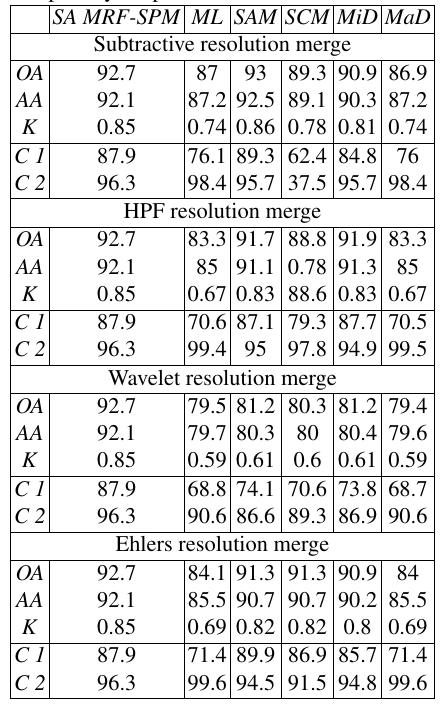
Table 2: the classification accuracy in percentage for each class of the the mangrove forest image, where OA , AA , k , and SA MRF- SPM denote the overall accuracy, average accuracy, kappa coef- ficient, and spatially adaptive MRF-SPM